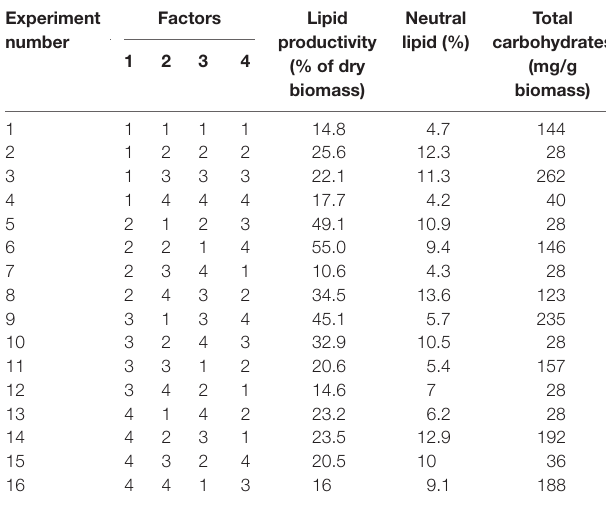
TaBle 2 | Orthogonal array (Oa) of designed experiments with output parameters. experiment Factors lipid neutral number productivity lipid (%)